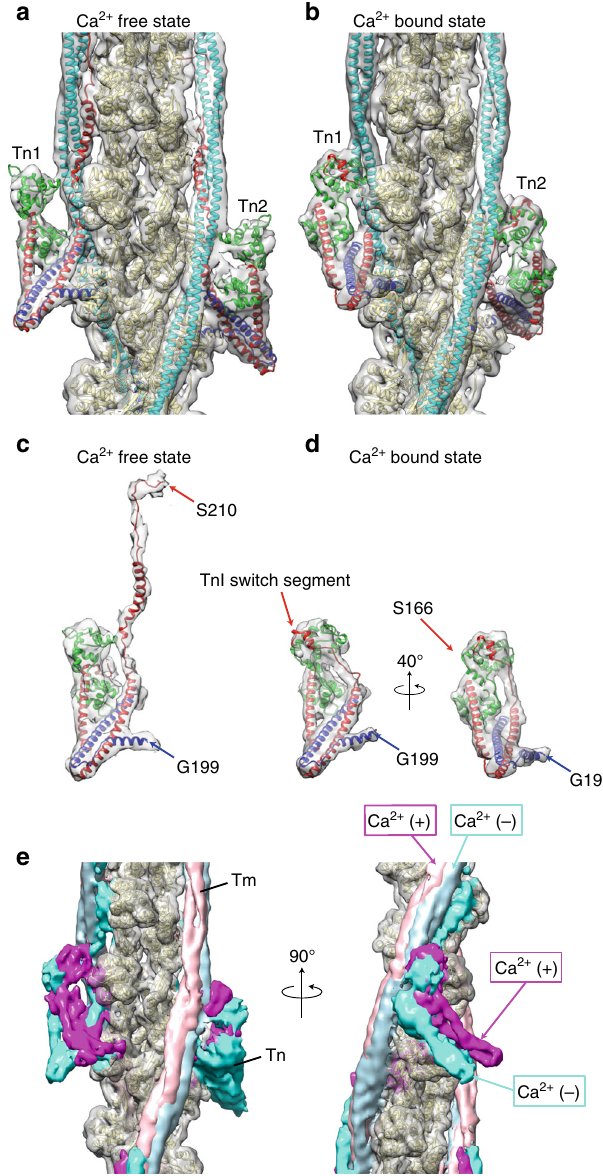
Fig. 3 Structural changes of the thin fi lament and Tn complex upon Ca 2 + binding to TnC. a , c Ca 2 + free state. b , d Ca 2 + bound state. c , d The Tn ternary complex extracted from the thin fi lament to show the good fi t of the model into the difference map. Models are colored as: actin, beige; Tm, light blue; TnI, magenta; TnT, dark blue; and TnC, green. e 3D volumes of the thin fi lament in the two states are superimposed with Tn and Tm in blue and light blue for the Ca 2 + free state and in magenta and light pink for the Ca 2 + bound state and actin in beige for both. Two different views are presented.